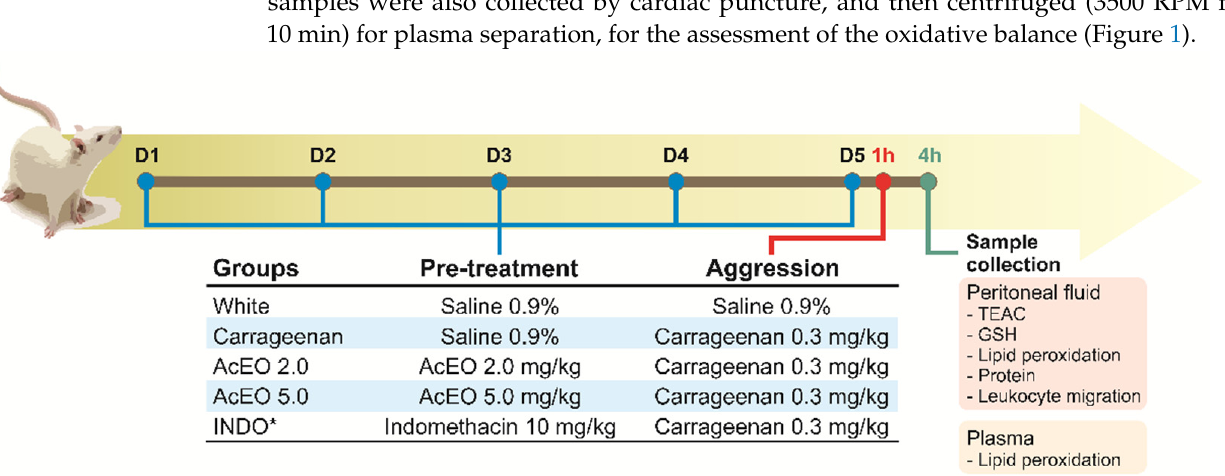
Figure 1. Experimental design. * Anti-inflammatory standard.